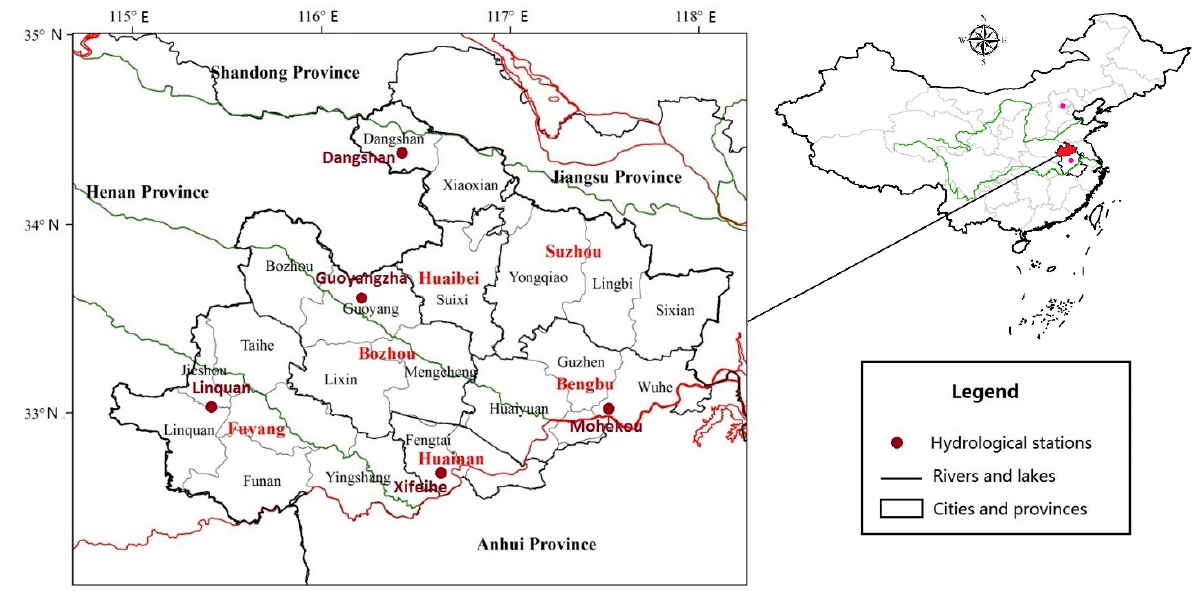
Figure 1. Distribution of regions and observation sites in northern Anhui province,